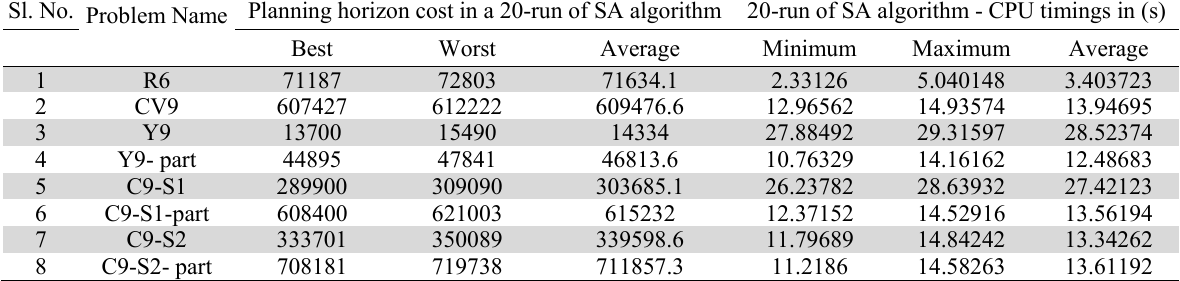
20-run PHC and CPU timing of proposed SA heuristic applied to equal area DFLP data set Sl. No. Problem Name Planning horizon cost in a 20-run of SA algorithm 20-run of SA algorithm - CPU timings in (s)